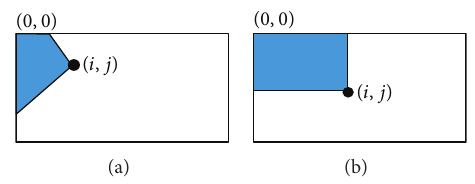
Figure 11: (a) Summed area of integral image and (b) summed area of rotated integral